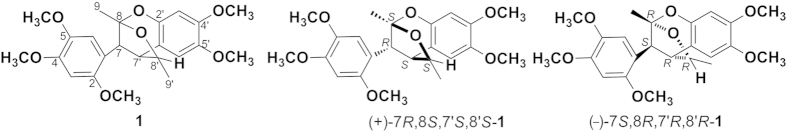
The chemical structures of 1, (+)−1 and (−)−1.